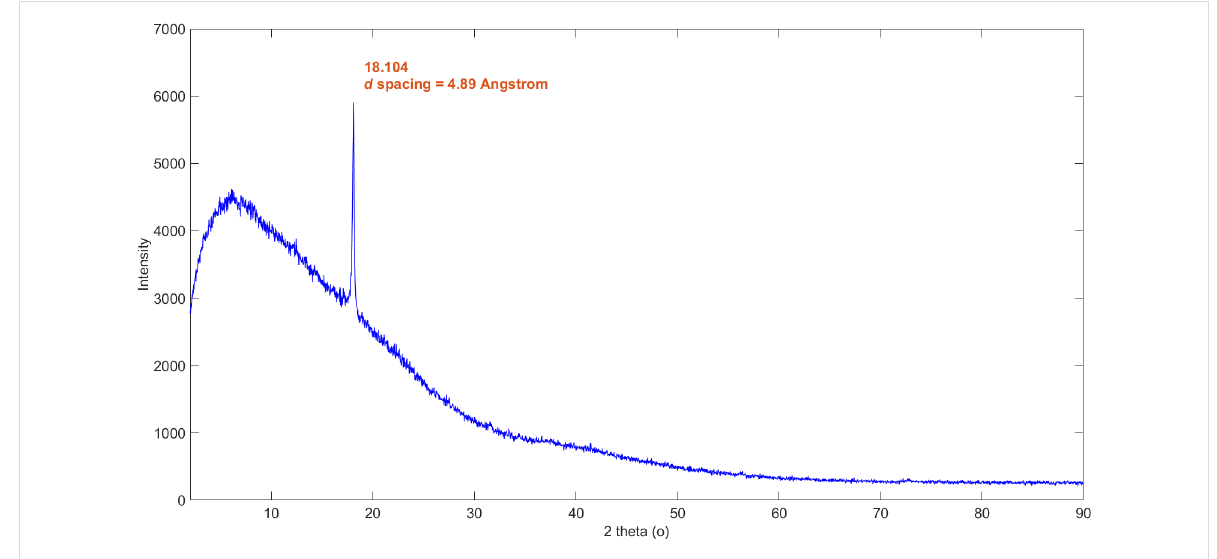
Figure 5: XRD of glassy carbon tubules, including the calculation of the interlayer spacing.